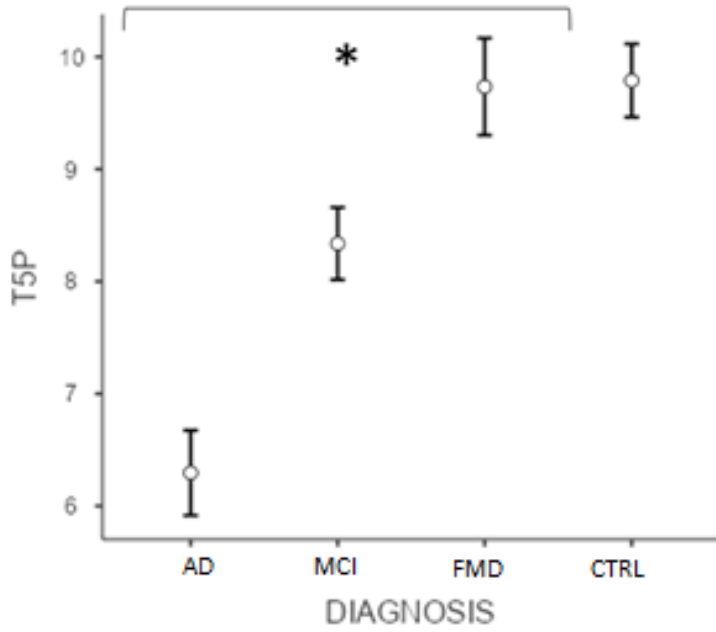
Figure 1. Differences between groups at MMSE total score. (* significant different, p < 0.001). AD = Alzheimer’s Disease; MCI = mild cognitive impairment; FMD = functional memory disorders; CTRL = controls.